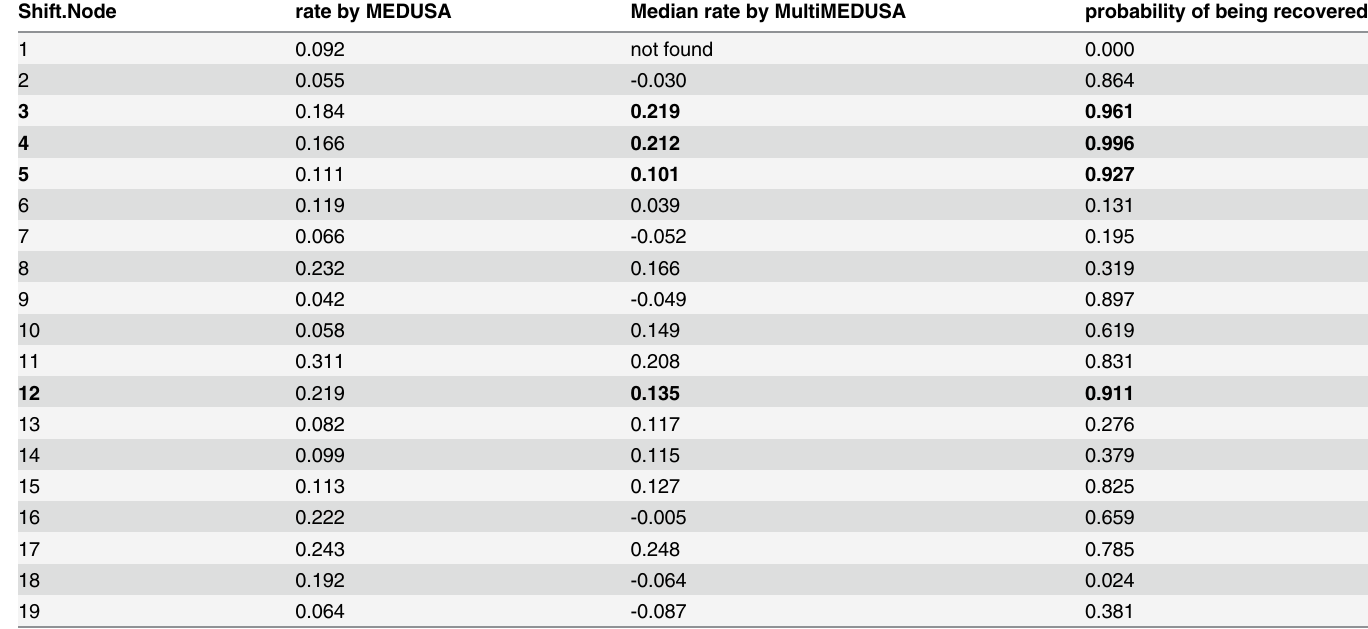
Table 2. Differences in rates estimated by MEDUSA on the MCC tree from the sample of trees from the posterior distribution and the MultiMEDUSA approach. Shift consistently recovered across the sample of trees in bold face.